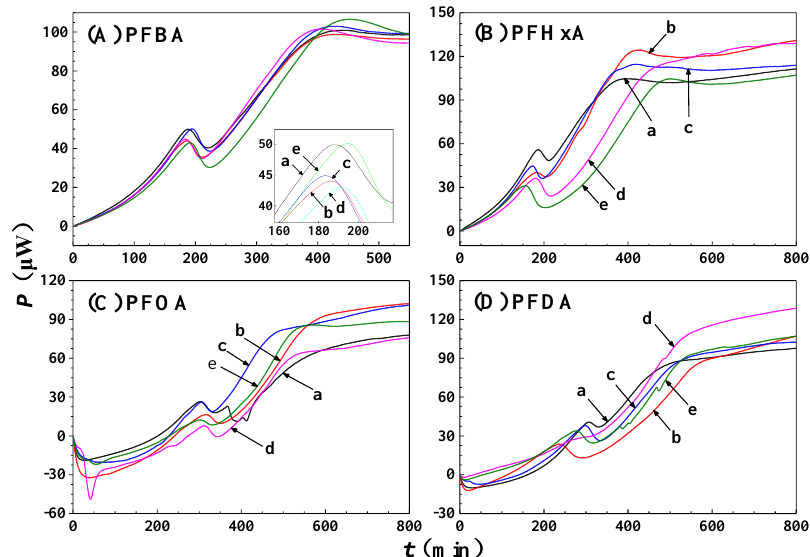
Figure 2. The power-time curves of GQ-9 grown at different concentrations of perfluorocarboxylic acid compounds (PFCAs) in Luria-Bertani (LB) medium. ( a ) 0 mg/L; ( b ) 20 mg/L; ( c ) 40 mg/L; ( d ) 80 mg/L; and ( e ) 160 mg/L.